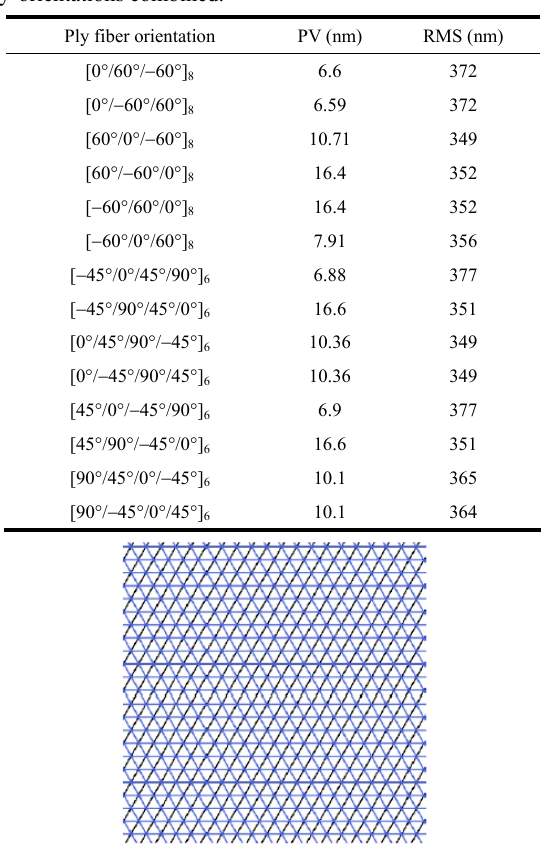
Table 1 Mirror surface deformation under the different ply-orientations combined.